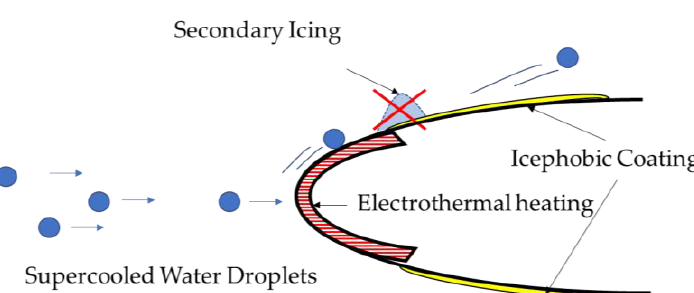
Figure 1. Scheme of the ICE-WIPS (Hybrid I ce-phobic C oating and E lectrothermal Heating W ing I ce P rotection S ystem).